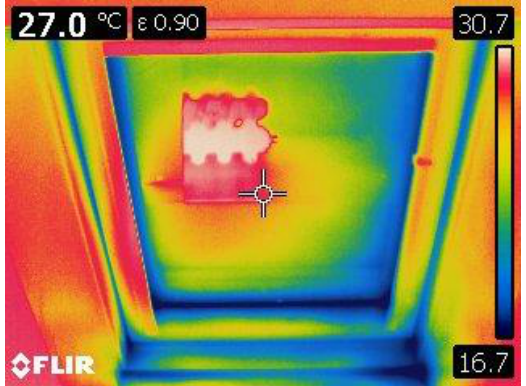
Figure A3. Illustrative infrared picture of a roof window. A multiple reflection of a heating body is